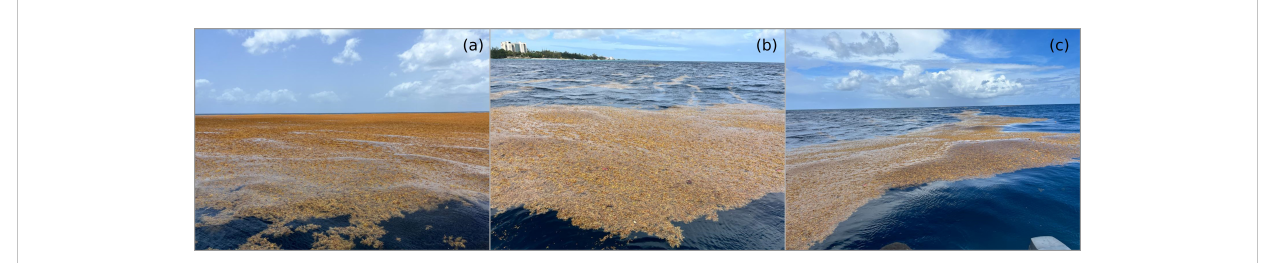
FIGURE 2 Pelagic sargassum aggregation states sampled off the coast of Barbados. (A) Large mat (>100 m in diameter), (B) small mat (10 m in diameter) and (C) windrows (7 m in